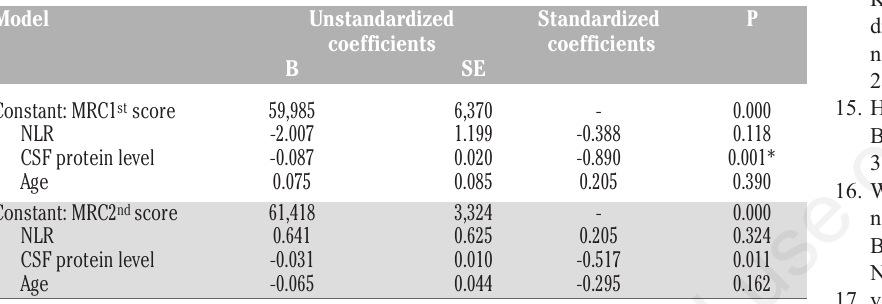
Table 3. Regression analyses to find prognostic predictor for Guillain Barré syndrome